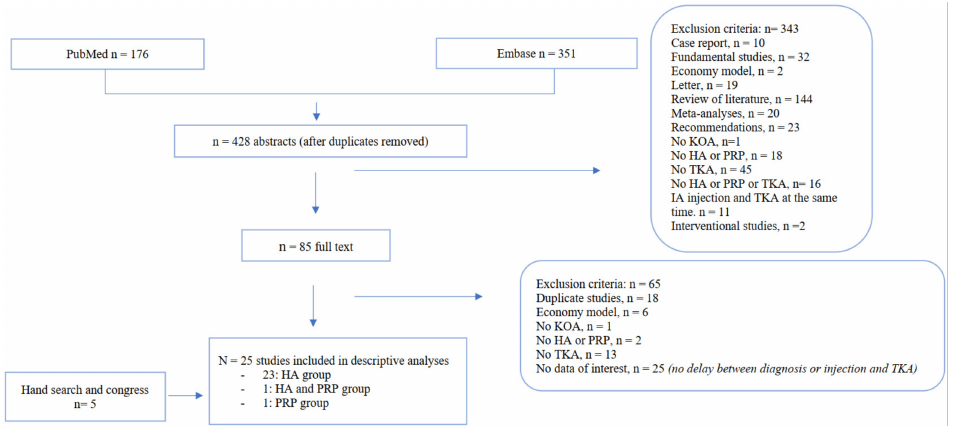
Figure 1. Flow chart of included studies. HA = hyaluronic acid; TKA = total knee arthroplasty; KOA = knee osteoarthritis, PRP = platelet-rich